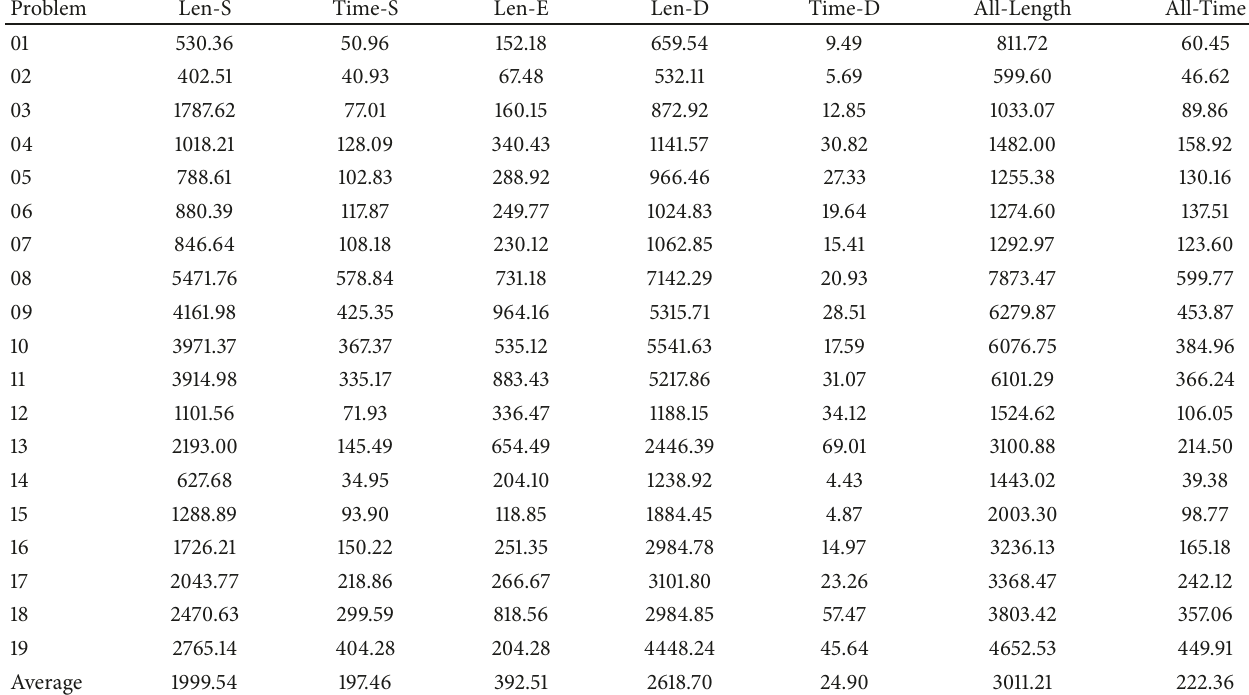
Table 6: Results of real-time addition and optimization